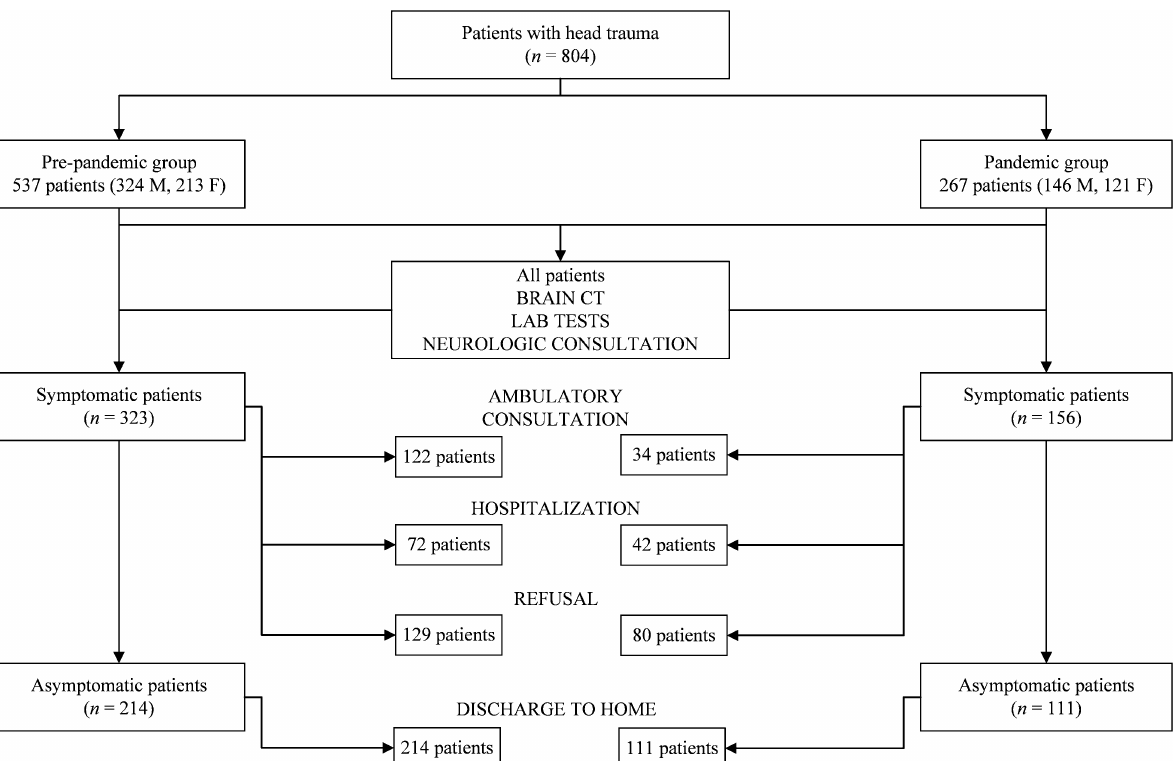
Figure 2. Diagnostic breakdown flowchart.